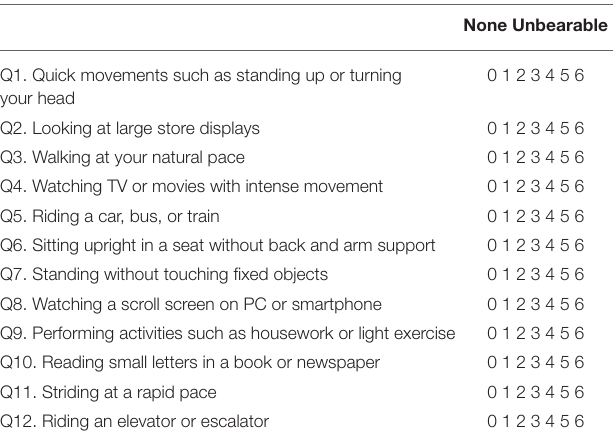
TABLE 2 | Niigata Persistent Postural-Perceptual Dizziness Questionnaire (8). Instructions: The purpose of this questionnaire is to identify difficulties in daily life that you may be experiencing due to dizziness. Please indicate your answer by circling the number that best describes the extent to which you have been affected during the past week. When you avoid performing these actions, you should circle the number